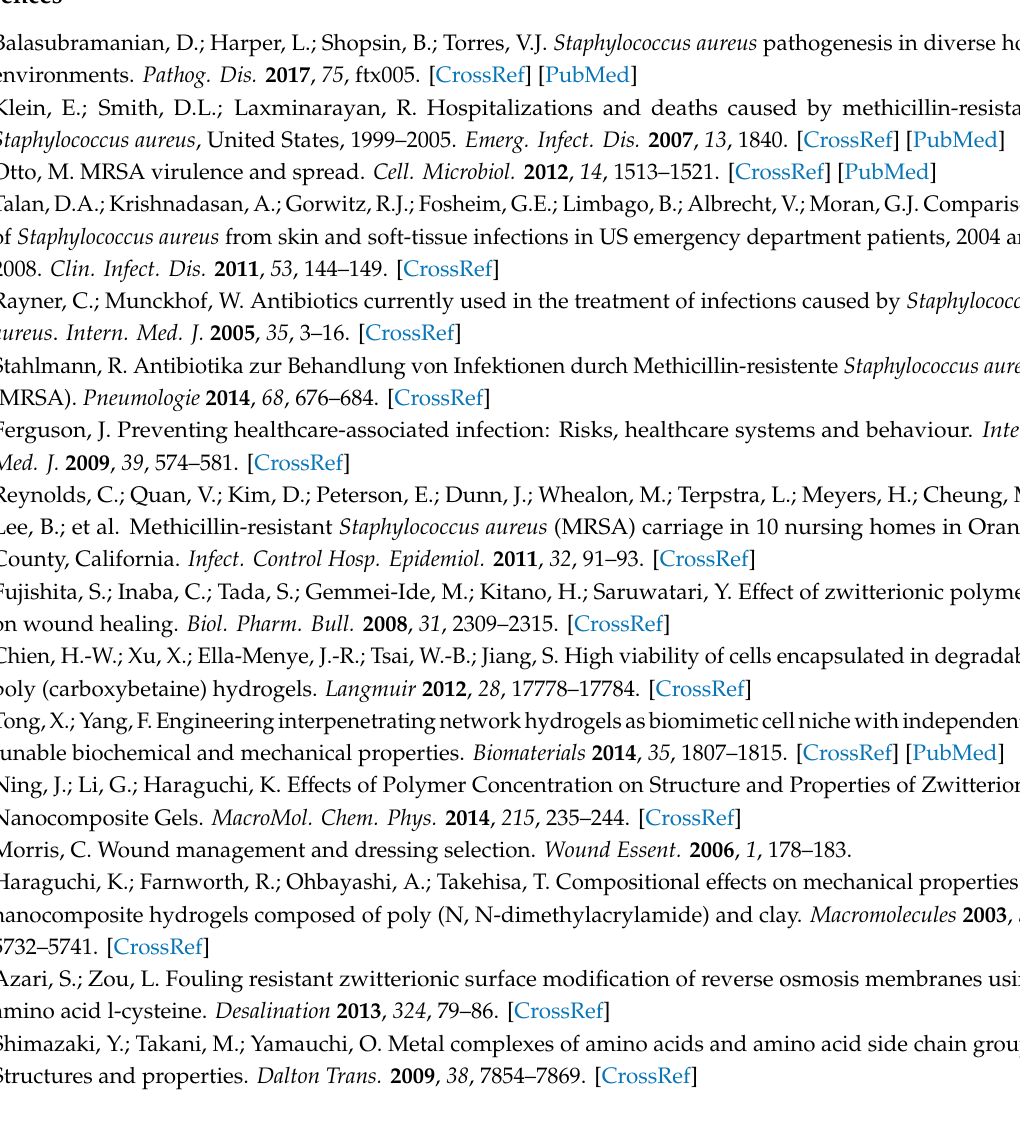
Figure S1. Anti-MRSA activity of copper release from hydrogels.; Figure S2. No significant cytotoxicities of